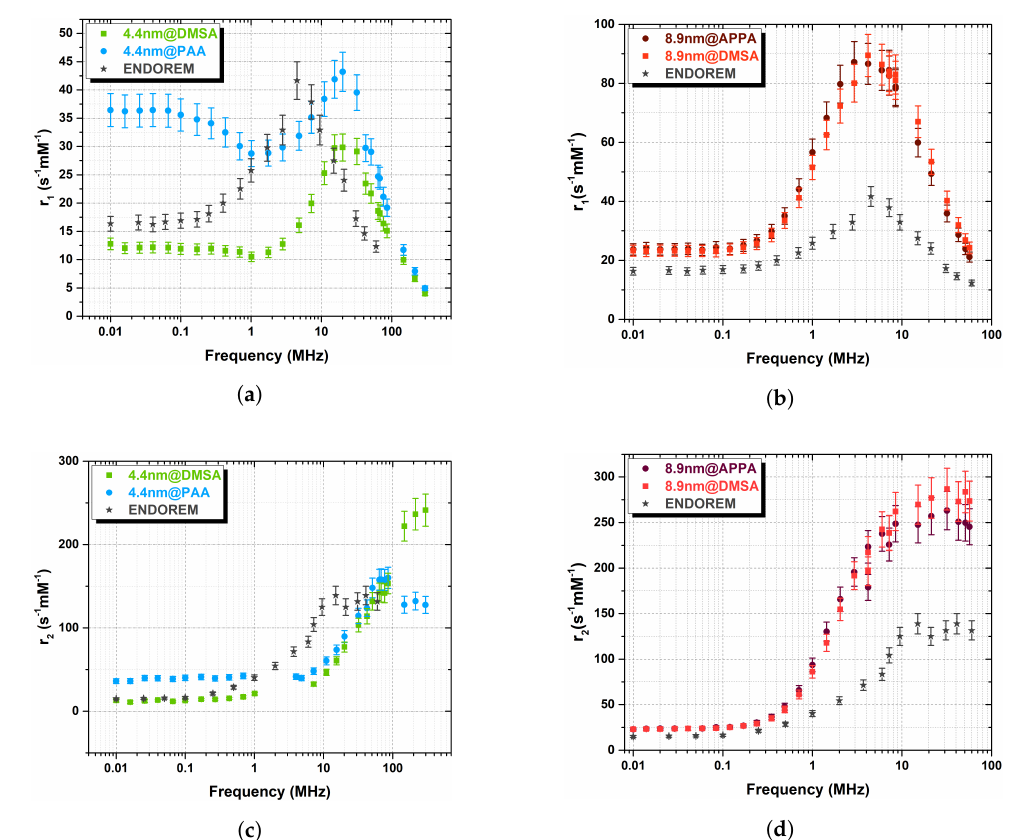
Figure 7. Longitudinal ( a , b ) and transverse ( c , d ) relaxivity 1 H-NMR profiles of ( a , c ) 4.4 nm samples (coated with DMSA and PAA), and of ( b , d ) 8.9 nm ones (coated with DMSA and APPA), collected at room temperature. Gray stars represent the Endorem values. The error bar is calculated a-priori to be 8% (see main text).